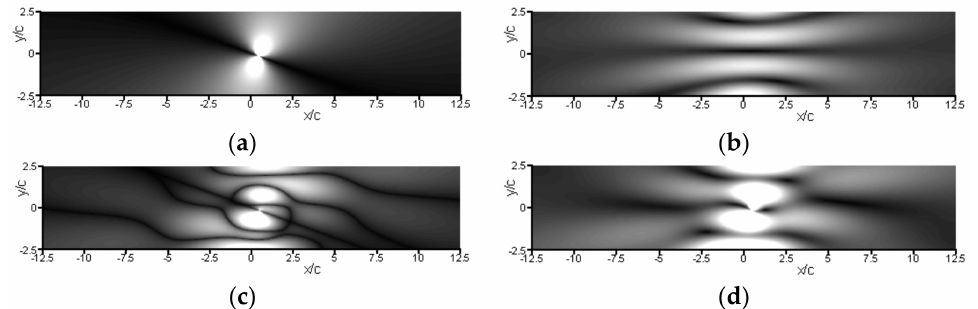
Figure 4. Low frequency ( St = 0.294) noise radiation from the trailing edge of an airfoil set at relatively high incidence ( α = 20 ◦ ). RMS pressure fields: ( a ) Incident field (1st term in Equation (64)); ( b ) top plus bottom wall reflected fields and their interaction (2nd, 3rd and last term in Equation (64); ( c ) incident and reflected fields’ interaction (4th and 5th terms in Equation (64)); ( d ) total field ( (cid:101) p RMS ( x ) , all terms in Equation (64)). For visualization purposes, all RMS pressure fields are normalized by A max and depicted over an amplitude range [0; 2] using 60-iso